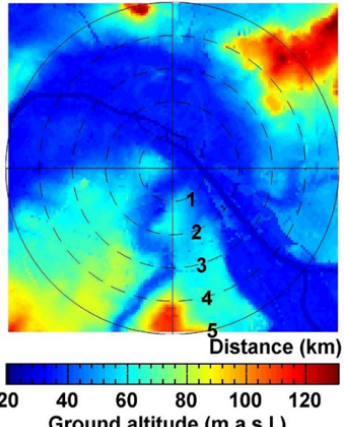
Figure 1. (a) The Doppler lidar installed on the tower roof during the VEGILOT campaign and (b) the measurement site in Paris with inside a circle with a 10km diameter demonstrating the maximum range of the PPI surface scan (© Google Earth satellite image).